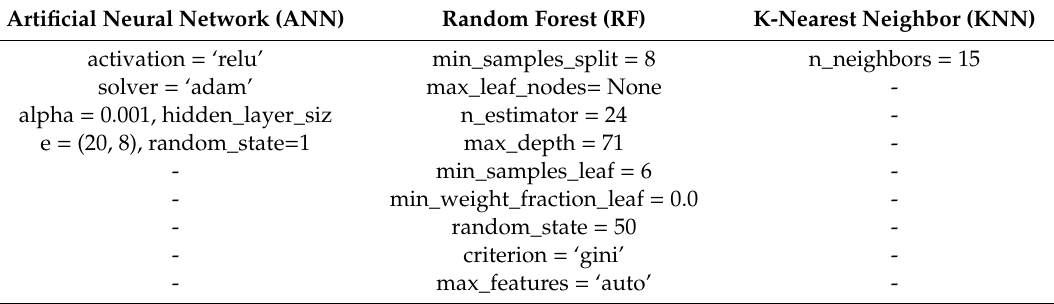
Table 1. The parameters that have been selected for the classifiers.